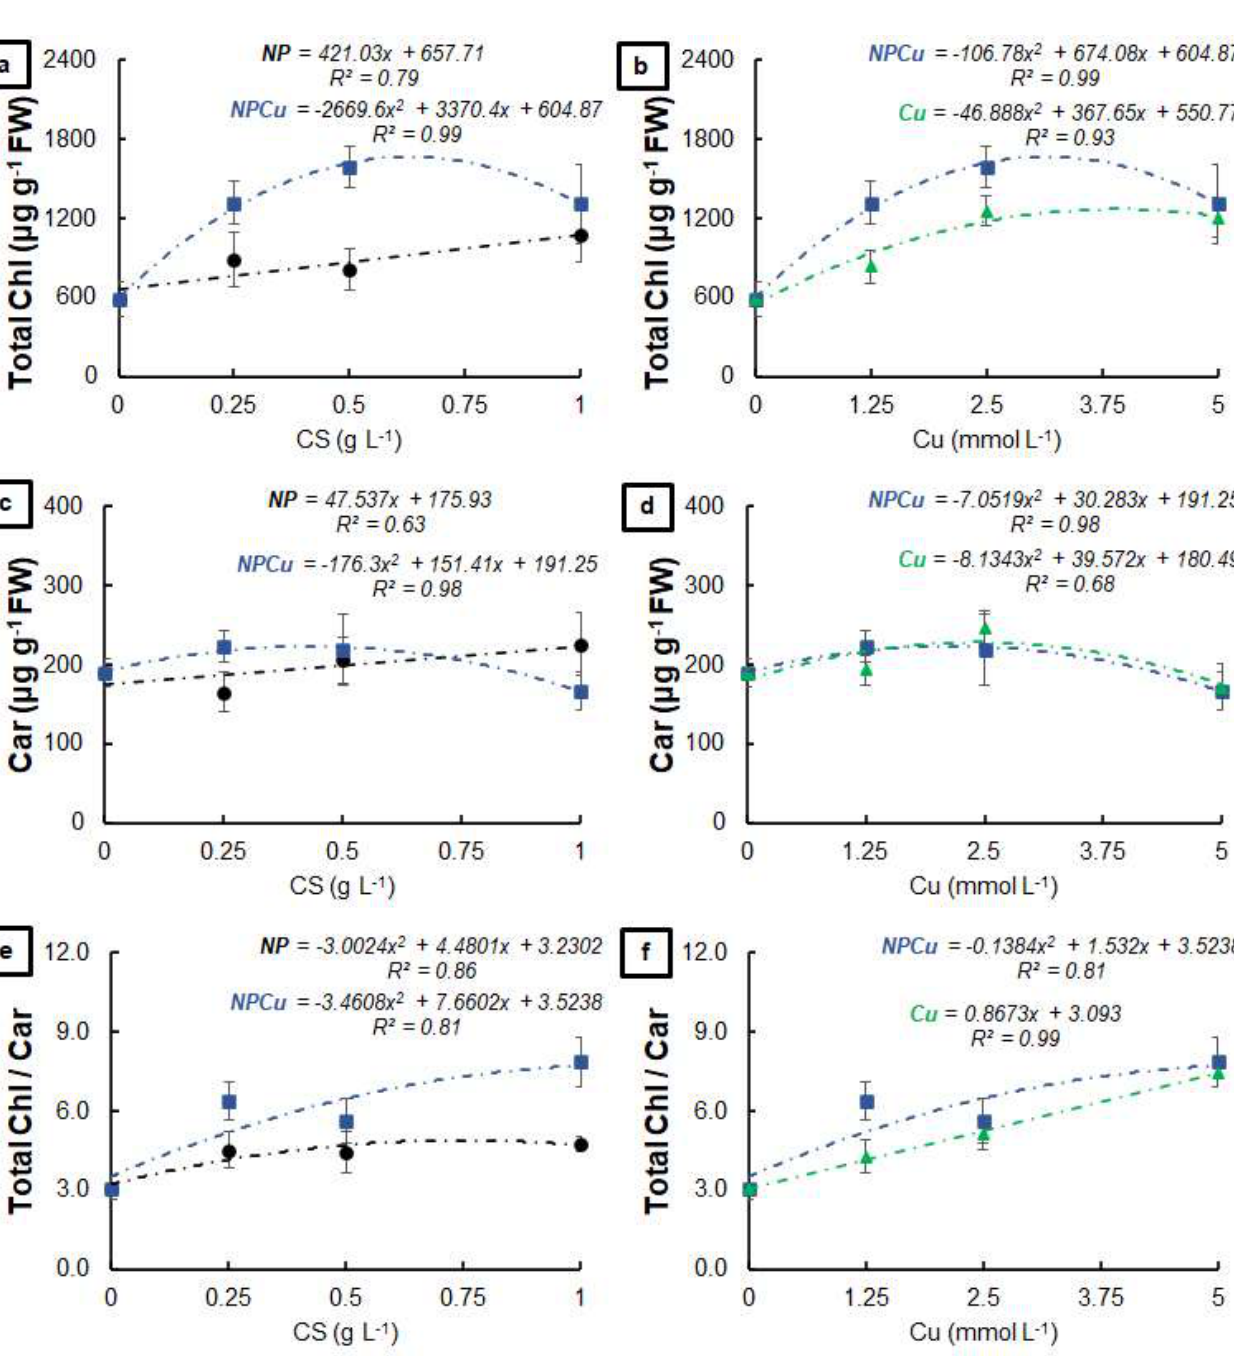
Figure 5. Total chlorophyll ( a , b ), carotenoids ( c , d ), and total chlorophyll/carotenoids ratio ( e , f ) of leaf discs of Coffea arabica cv. IPR 100 at days after infection (DAI) with H. vastatrix . Before infection, the discs were treated with distilled water as a control (CONT), chitosan nanoparticles without Cu 2+ ions (NP), chitosan nanoparticles containing Cu 2+ ions (NPCu), and free Cu 2+ ions (Cu). The formulations were diluted in distilled water, obtaining the corresponding concentrations of chitosan (CS) in NP and NPCu treatments (0.25; 0.5; 1 g L −1 ) and of Cu 2+ ions (1.25; 2.5; 5 mmol L −1 ) in NPCu and Cu treatments. Results are expressed as mean ( n = 4) ± standard error. The model and coefficient of determination (R 2 ) are also shown ( p < 0.05).